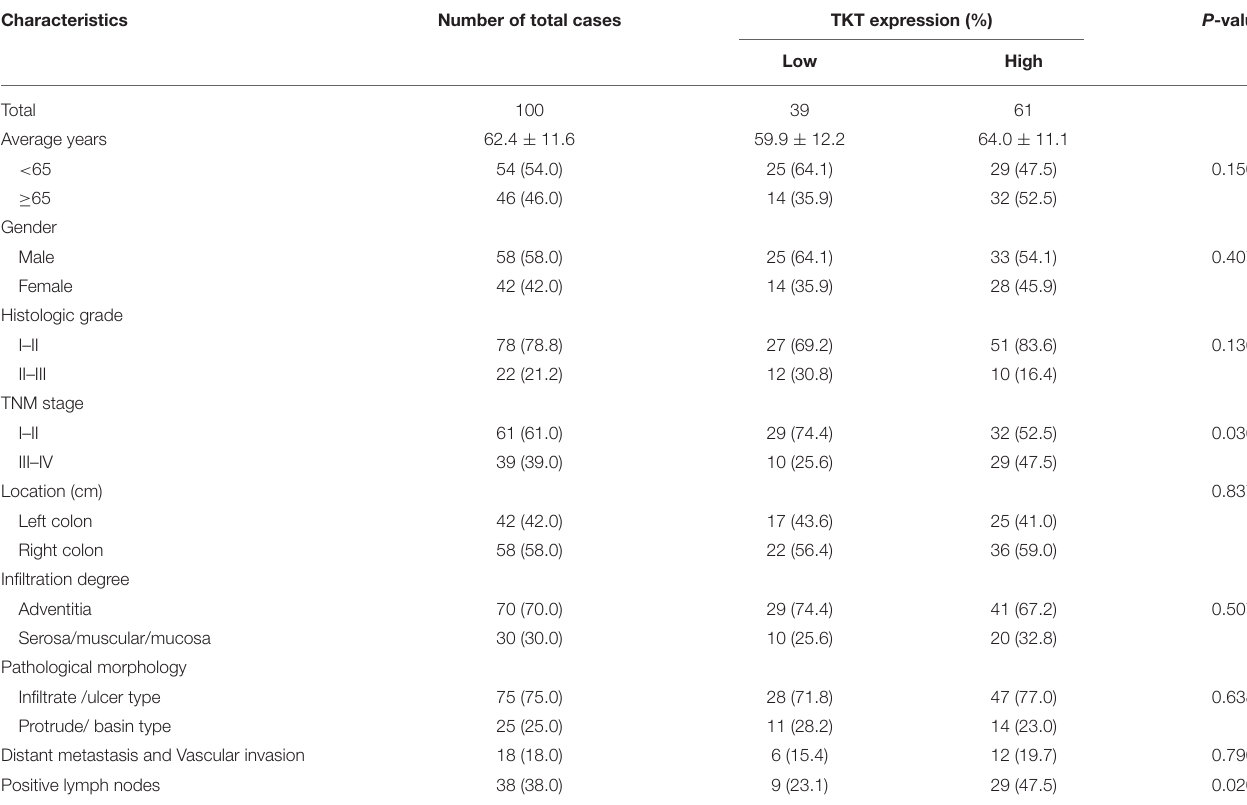
TABLE 1 | Relationships between TKT expression and clinicopathological characteristics in 100 colon adenocarcinoma cases.